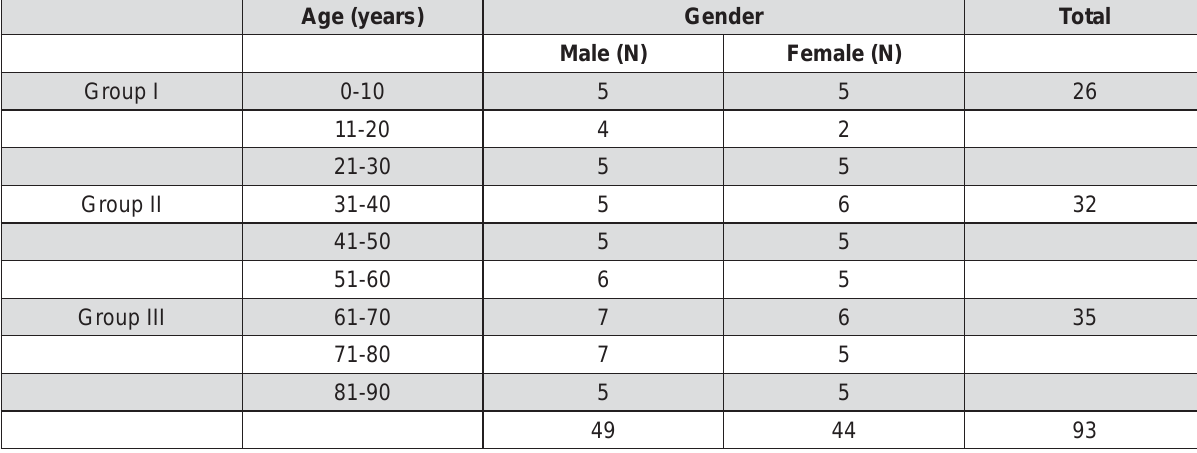
Figure 1- Distribution of individuals according to age (decade of life) and